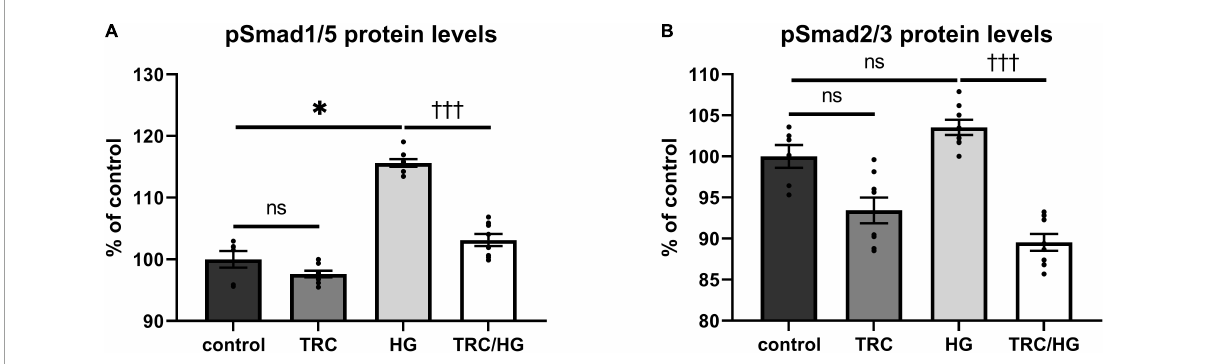
FIGURE7 Effect of TRC105 on hyperglycemia-induced Eng signaling pathway in HAoECs. (A) pSmad1/5 protein levels; (B) pSmad2/3 protein levels. For Smad signaling analysis, cells were serum-starved in EBM-2 medium for 22 h and then pretreated with 300 µ g/ml TRC105 for 90 min. Then, cells were stimulated with 45 mM HG for 30 min after TRC105 pretreatment. Data are presented as mean ± S.E.M ( n = 6). ns, p ≥ 0.05; * p < 0.05, using Kruskal–Wallis test for comparisons among control, TRC and HG, and ††† p < 0.001, using Mann–Whitney test for comparison between HG vs . TRC/HG.